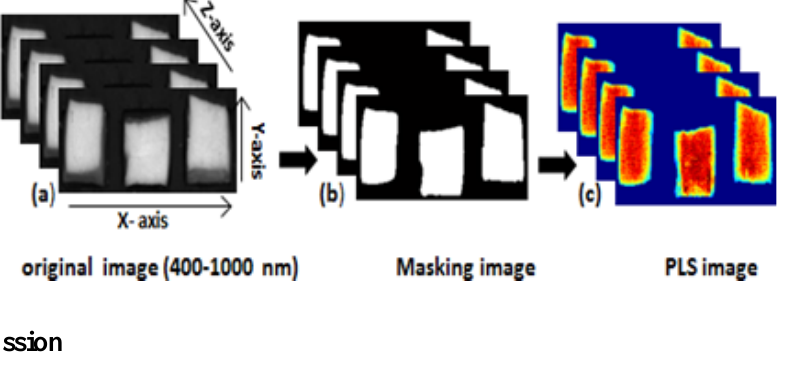
Figure 3. Image processing steps for generating PLS images: ( a ) Original image; ( b ) Masking image and ( c ) PLS image.